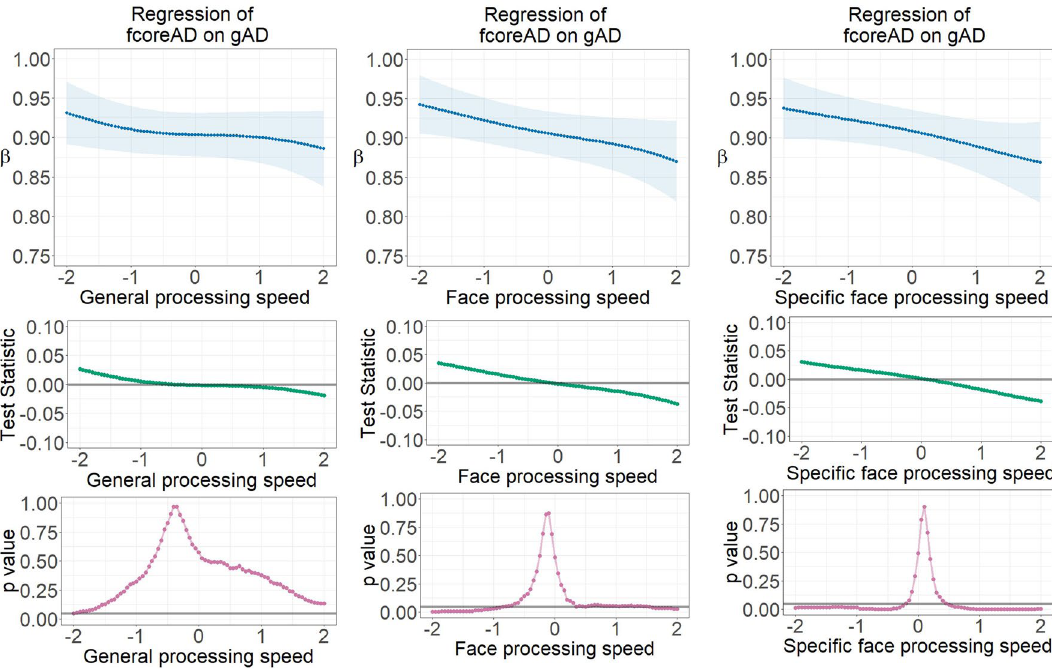
Figure 4. Parameter gradients indicating regressions of fcoreAD on gAD across continuously assessed processing speed ability scores using LSEM, namely (1) general processing speed ability, (2) face processing speed ability, and (3) specific face processing speed ability with general speed controlled for. The upper row displays variations of locally estimated AD factor regressions across processing speed ability scores—AD factor regression parameter functions. The middle row provides the course of the test statistic across processing speed ability scores as estimated with the permutation test. The bottom row displays the pointwise p -value curve, with p = .05 displayed as a threshold (see the gray horizontal line). β—Standardized regression weight; gAD—Axial diffusivity in global brain fibers; fcoreAD—Axial diffusivity of core face network